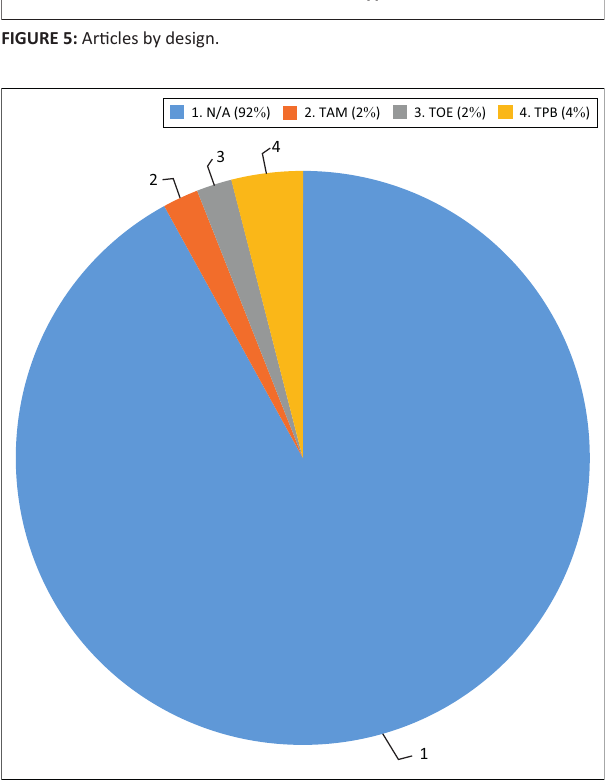
FIGURE 6: Articles by framework.